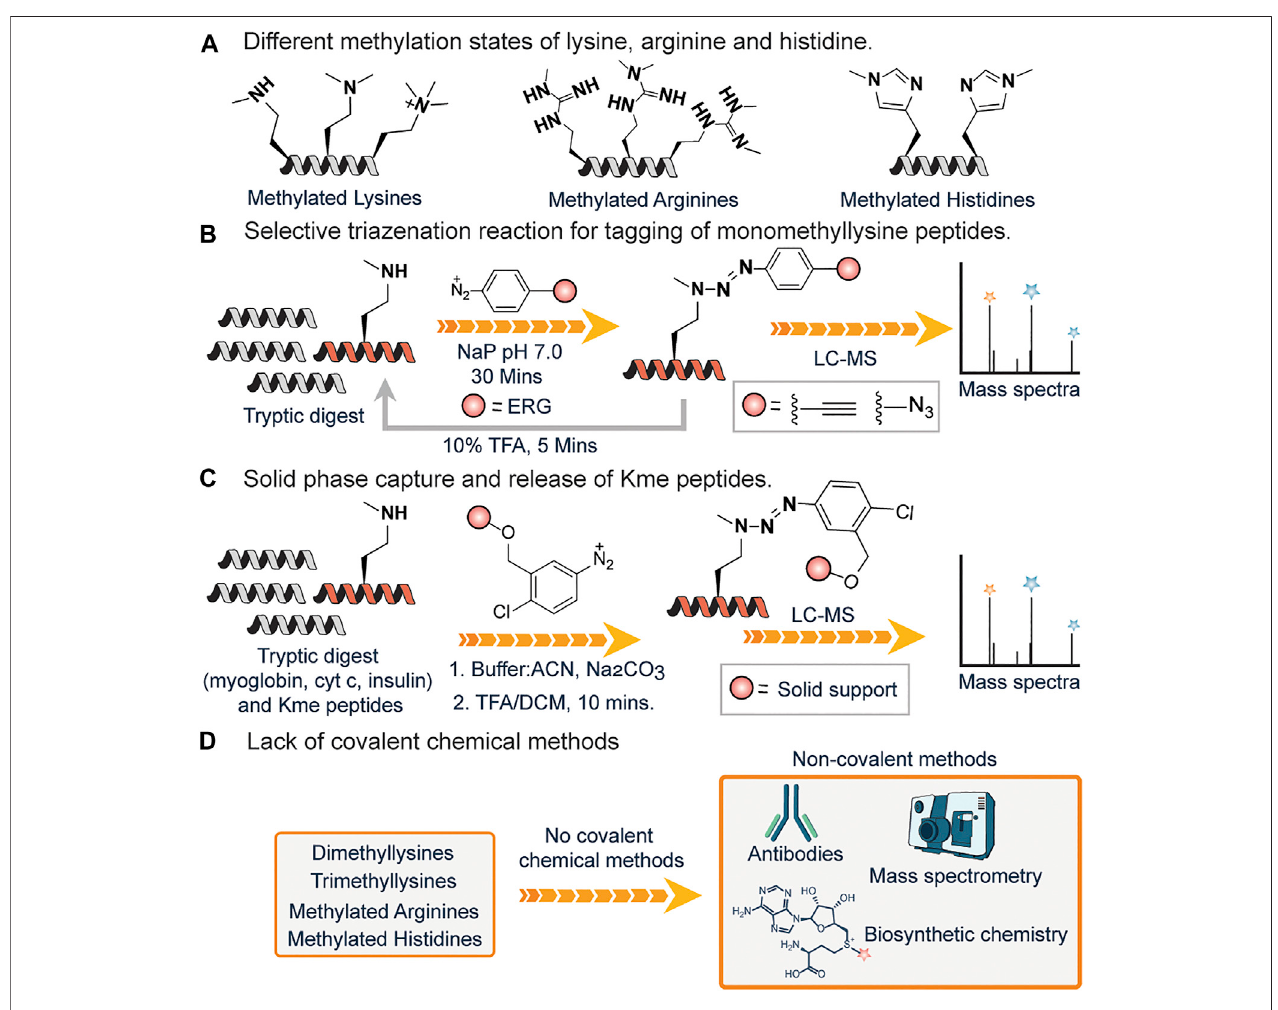
FIGURE 6 | (A) The different methylation states of lysine, arginine, and histidine. (B) A selective triazenation reaction for labeling and enriching monomethyl lysine KMe post-translational modi fi cations. (C) On-resin capture ofKMe peptides fromatryptic digestofmyoglobin,cytochromec, andinsulinspiked withKMe peptides. (D) Lack of covalent chemical strategy for tagging of dimethyl lysine, trimethyl lysine, methylated arginines and histidines.